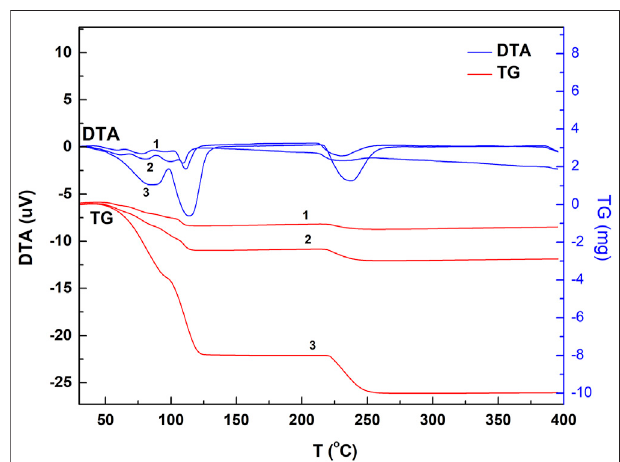
FIGURE 1 | DTA and TG spectrogram of the chalcanthite crystals of different weight. Note: upper curves 1, 2, and 3 are DTA pro fi les of low-, medium-, and high-weight chalcanthite crystals, respectively, while lower curves 1, 2, and 3 are TG pro fi les of low-, medium-, and high-weight chalcanthite crystals,